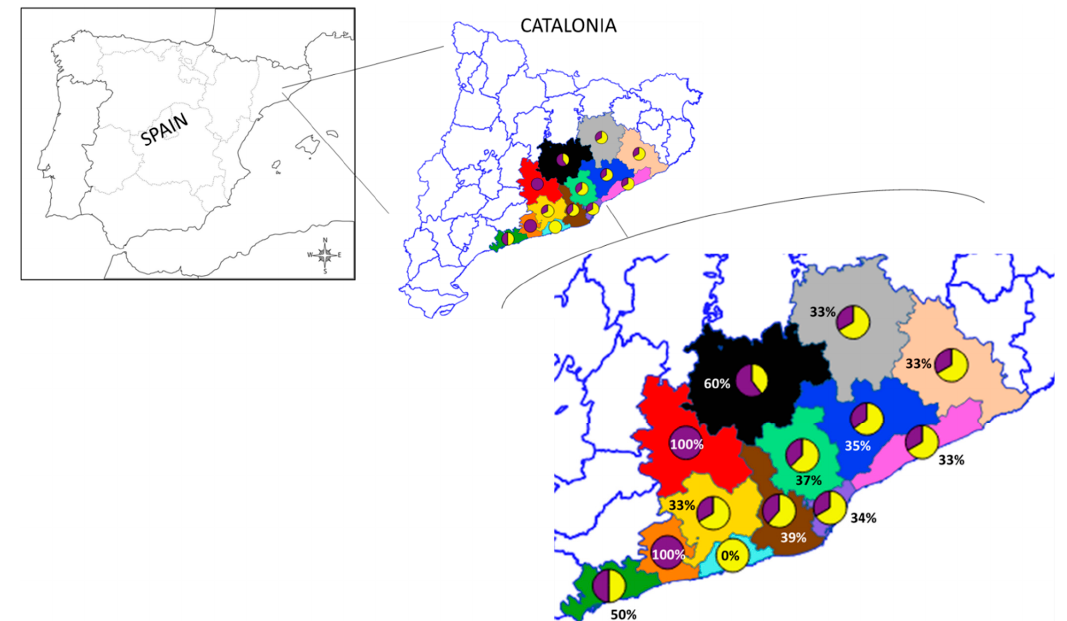
Figure 3. The map shows the counties where hedgehogs were found. Pie charts represent the occurrence of wild hedgehogs positive for AMR genes from the total number of sampled individuals for the corresponding study areas: green—Tarragon è s ( n = 2); orange—Baix Pened è s ( n = 1); azure—Garraf ( n = 2); yellow—Alt Pened è s ( n = 3); brown—Baix Llobregat ( n = 13); red—Anoia ( n = 1); Black—Bages ( n = 5); mint—Vall è s Occidental ( n = 38); purple—Barcelon è s ( n = 17); blue—Vall è s Oriental